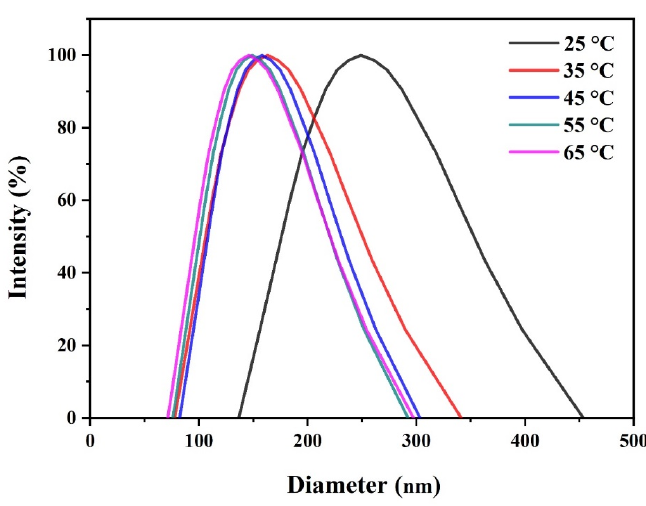
Figure 6. DLS measurement of PNI-C 60 micelles under different temperatures. Table 1. DLS measure results of PNI-C 60 under different temperatures. Temperature